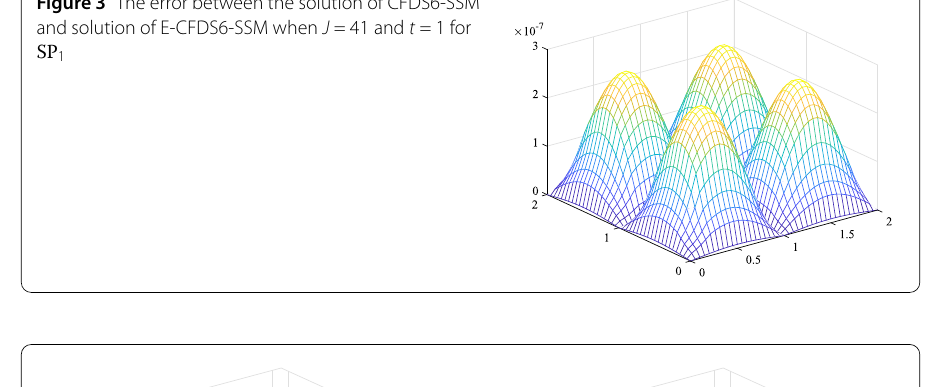
Figure 3 The error between the solution of CFDS6-SSM and solution of E-CFDS6-SSM when J = 41 and t = 1 for SP